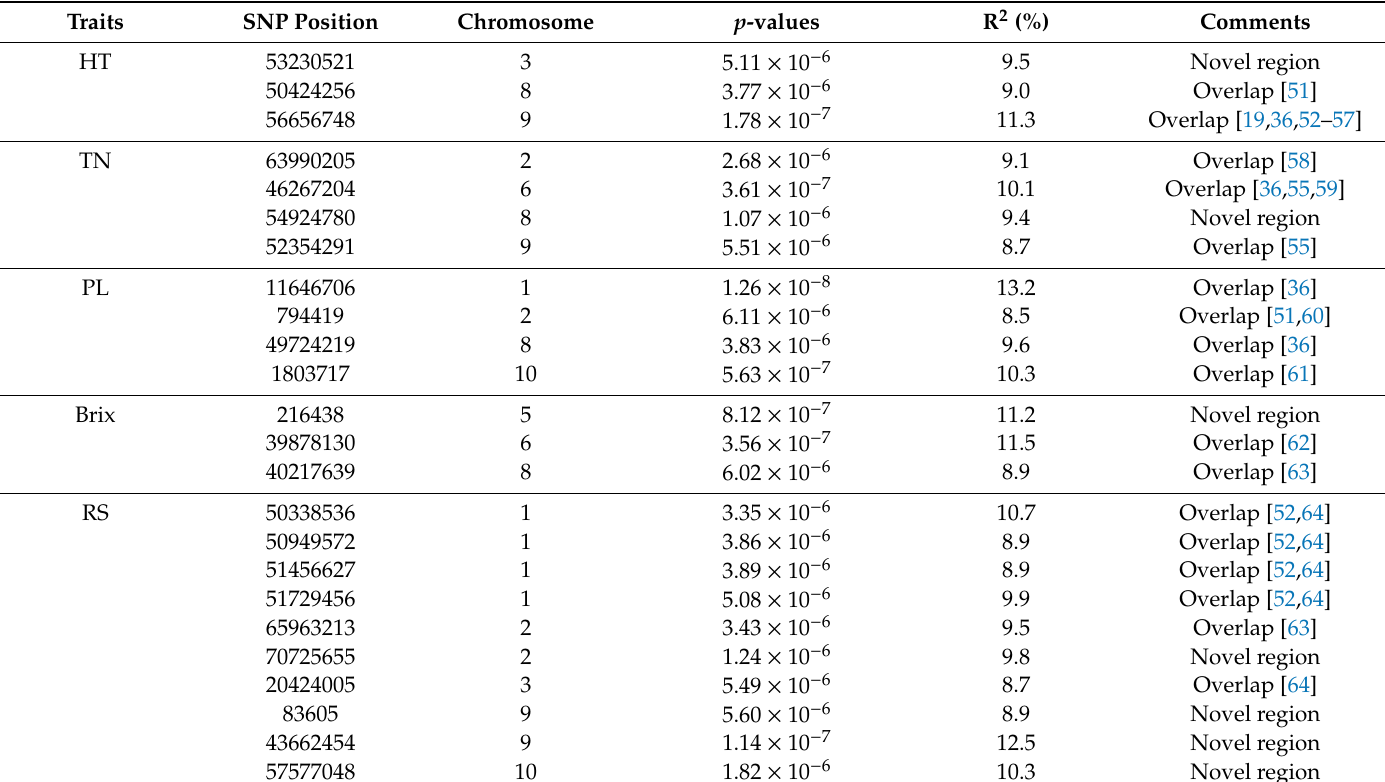
Table 4. Significant associations of single nucleotide polymorphism (SNP) with traits of plant height (HT), tiller number (TN), panicle length (PL), Brix, and reducing sugar (RS) in the population across three